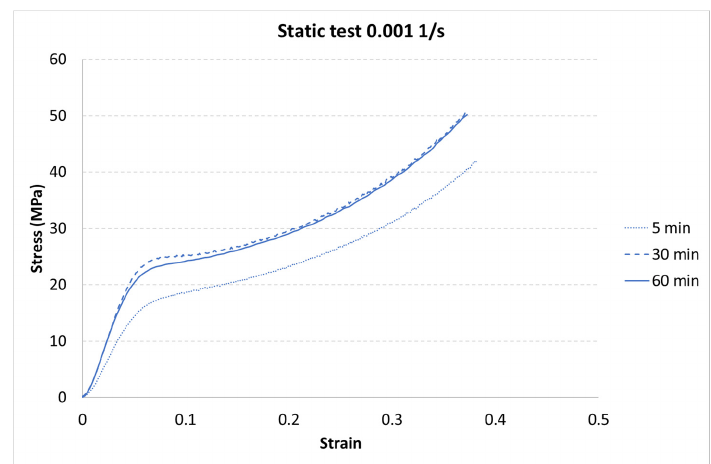
Figure 9. Results of the static test (strain rate of 0.001 1/s) of durable resin for curing times of 5, 30, and 60 min for UV and heat exposure.